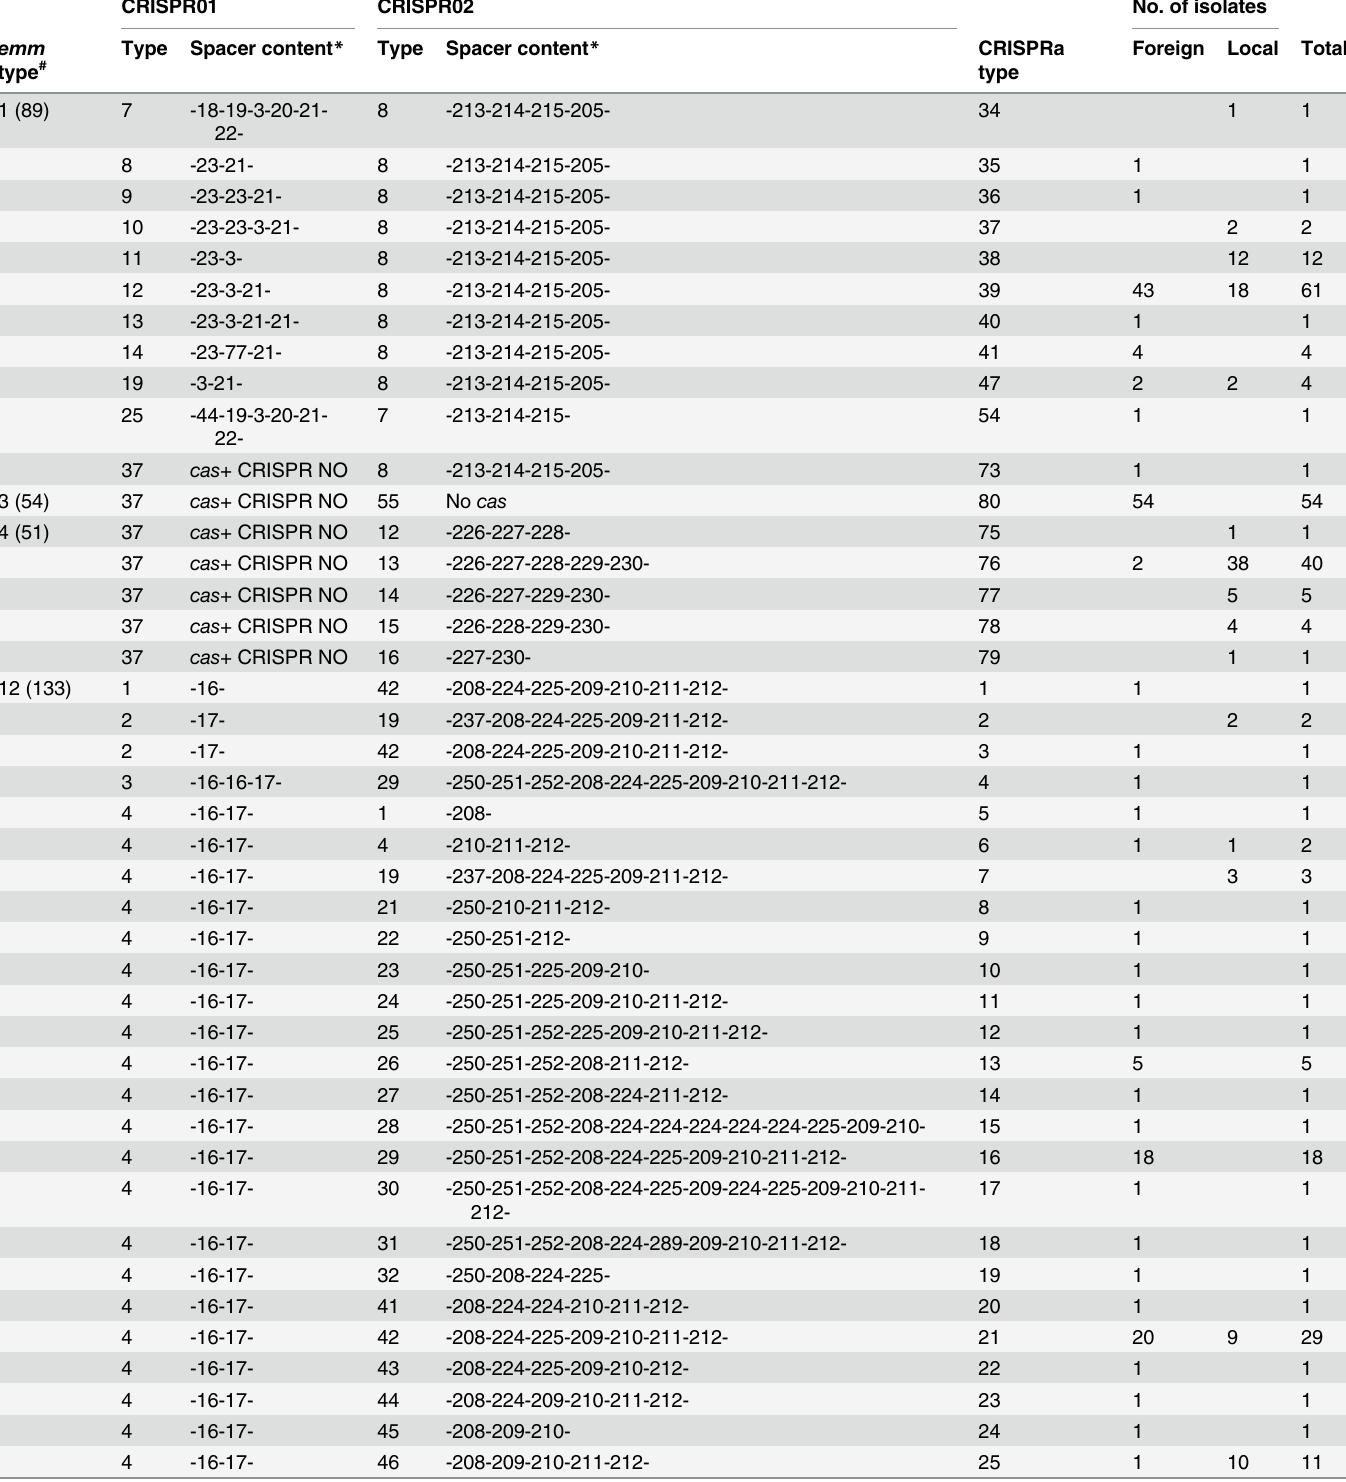
Table 2. The distribution of emm type, CRISPR01, CRISPR02, and CRISPRa type among local and foreign GAS